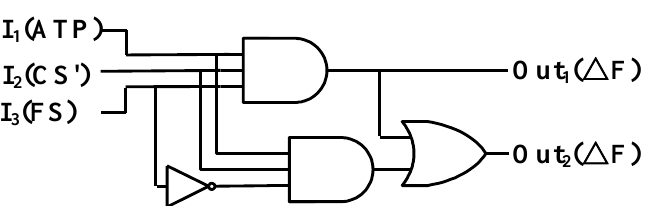
Figure 4. The AND-NOT-AND-OR logic gates of the DNA machine.